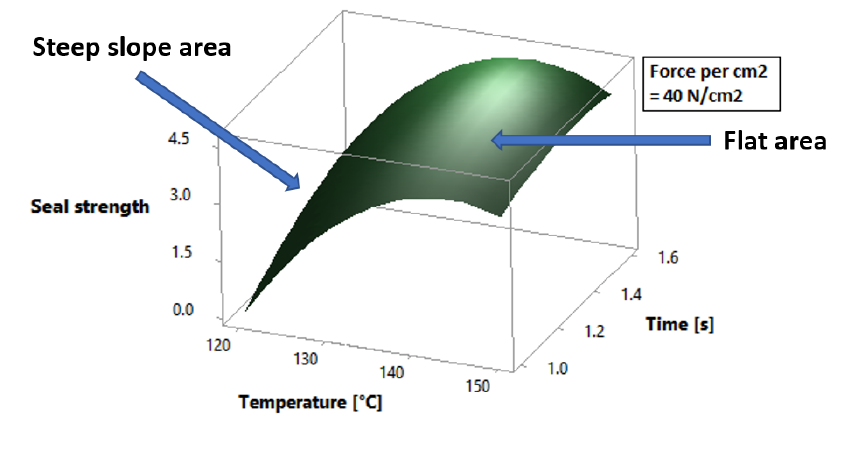
Figure 5 – Surface plot of Seal strength vs. Time and